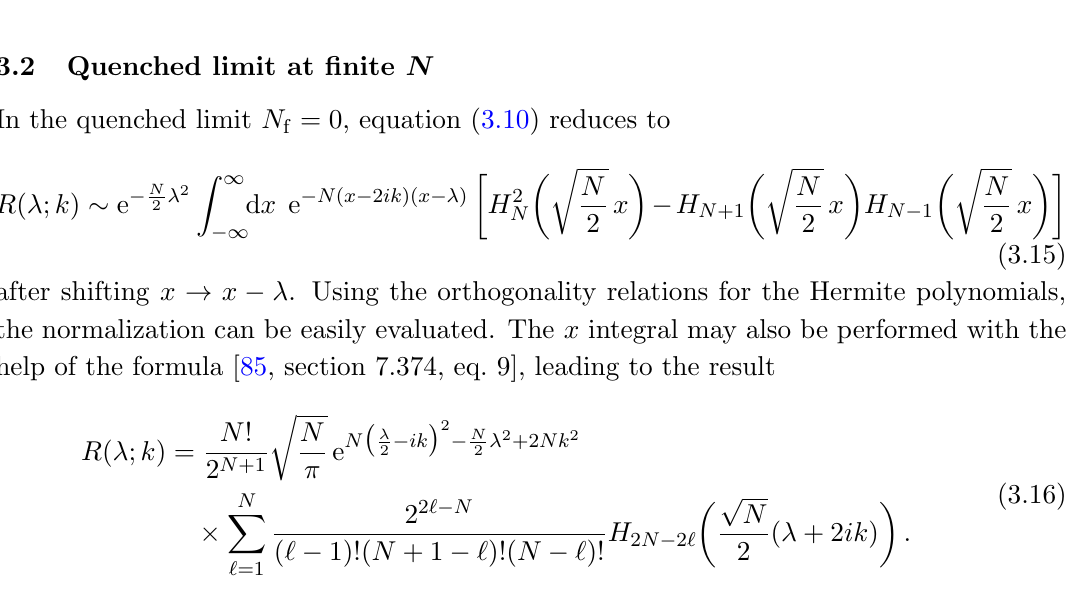
Figure 4 . Quenched spectral density at k = 0. It is an even function of (cid:21)